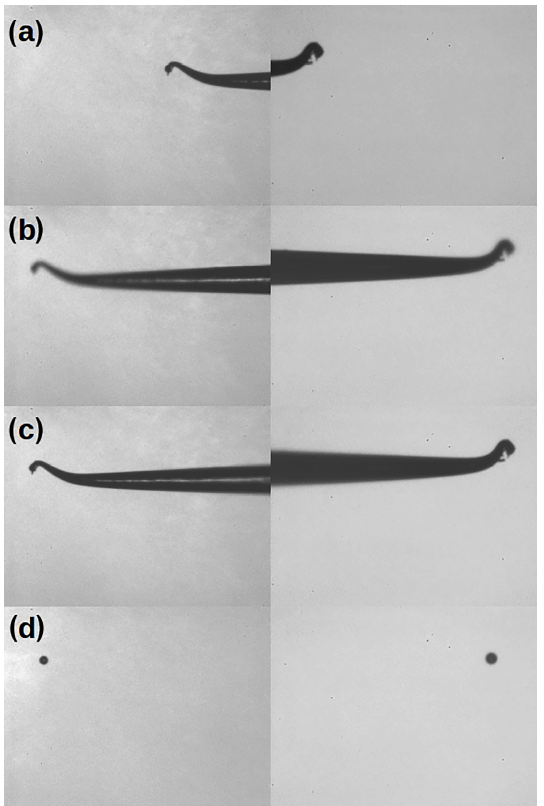
Figure 9. Stereo images of the tungsten needle taken during the alignment procedure described in Sect. 2.3.1. Needle at the edge of the trigger FOV (a) . Needle tip marks the particle position when the CTA shutters have been opened and the illumination flash is fired at an assumed airspeed of 250ms − 1 (b) . Focal planes of the CTAs have been adjusted to position (depth) of the needle tip (c) . Cross- check of the alignment with slowly moving water droplets in the laboratory using a illumination trigger delay scaled to the differ- ences in airspeed between laboratory and aircraft operation (d)